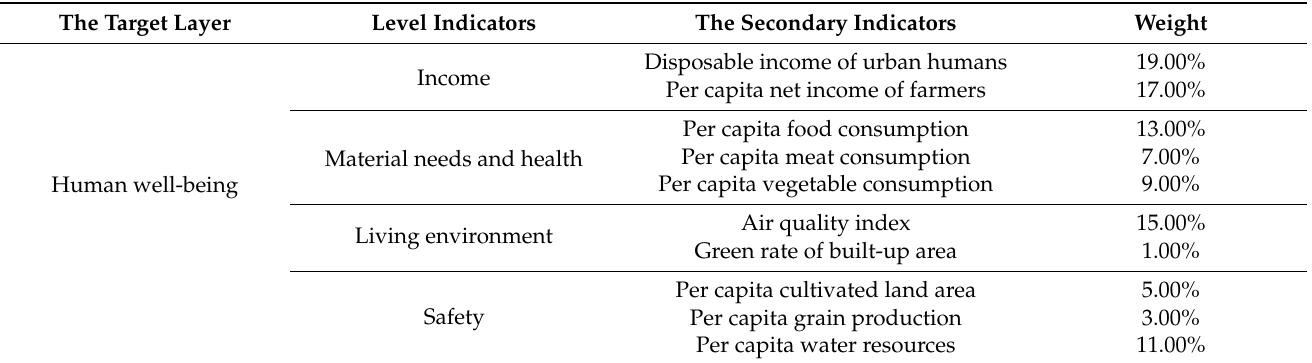
Table 1. The human well-being index system of humans in Guanzhong Plain urban agglomeration. The Target